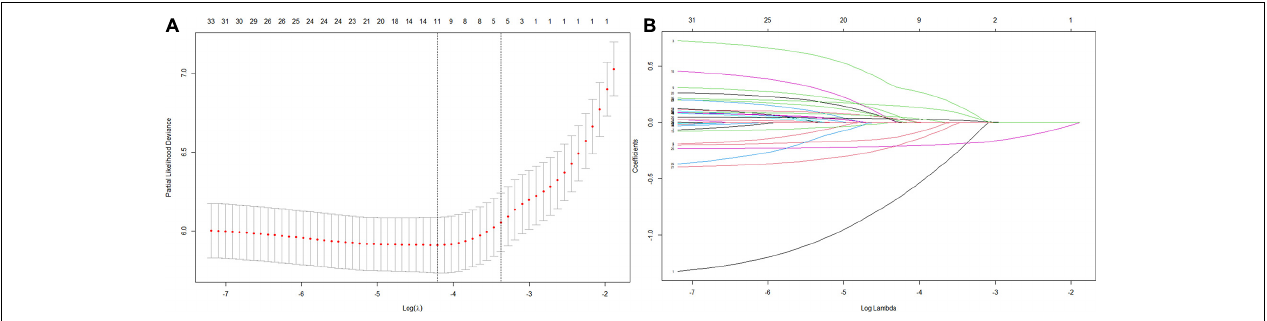
FIGURE 1 | Variables selection using the least absolute shrinkage and selection operator (LASSO) Cox regression model. (A) Tuning parameter ( λ ) selection in the LASSO model used 10-fold cross-validation via 1 standard error (SE) of the minimum criteria (the 1-SE criteria). (B) LASSO coefficient profiles of the 35 variables.